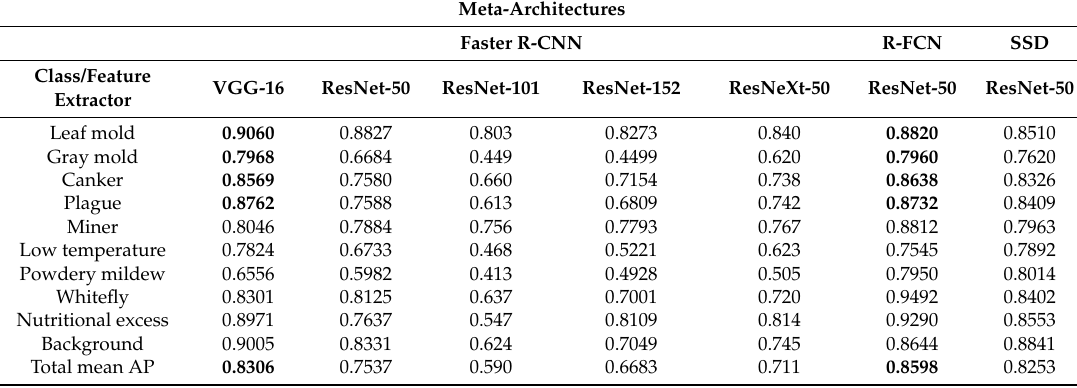
Table 4. Detection Results of Our Proposed System using Deep-Learning Meta-architectures and Feature